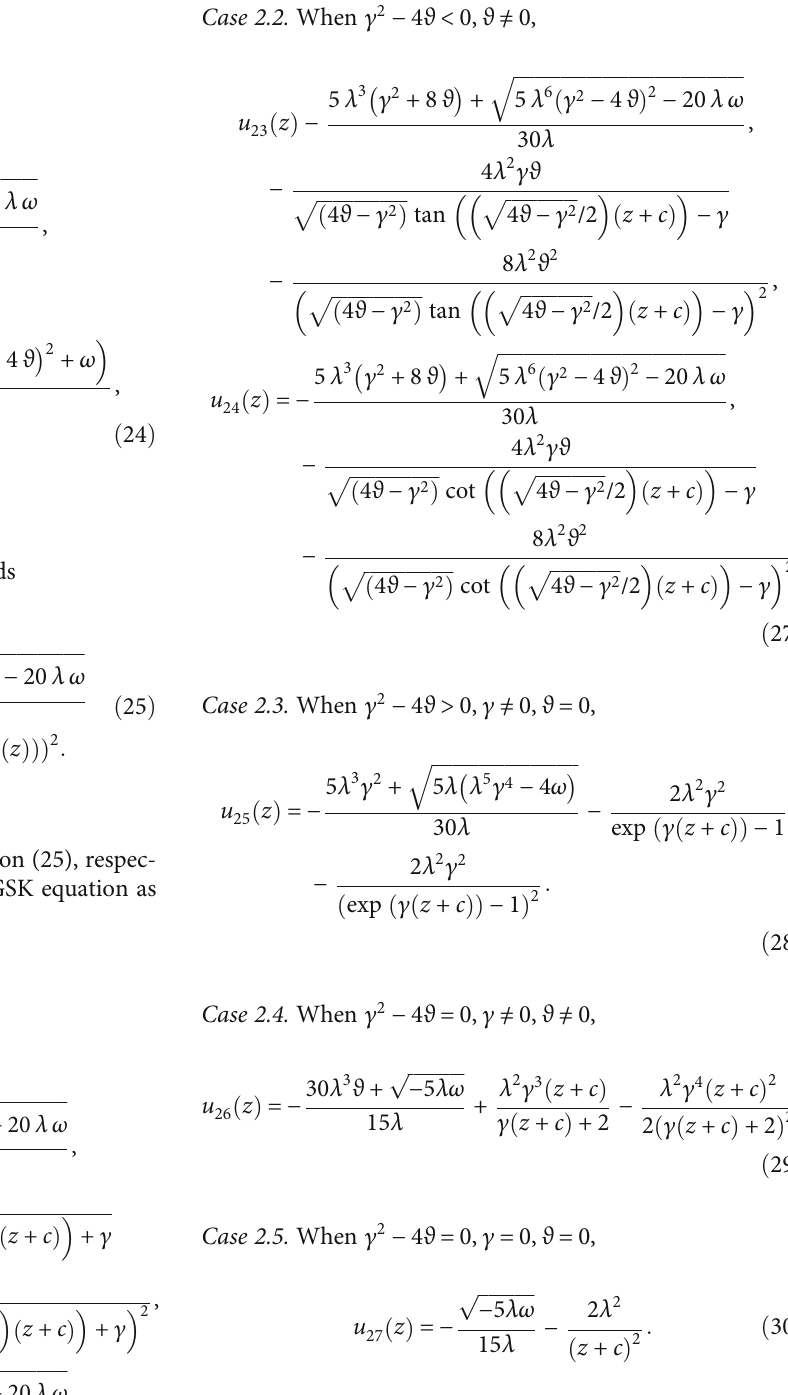
4 λ 2 γϑ p γ 2 − 4 ϑ p ffiffiffiffiffiffiffiffiffiffiffiffiffiffi γ 2 − 4 ϑ